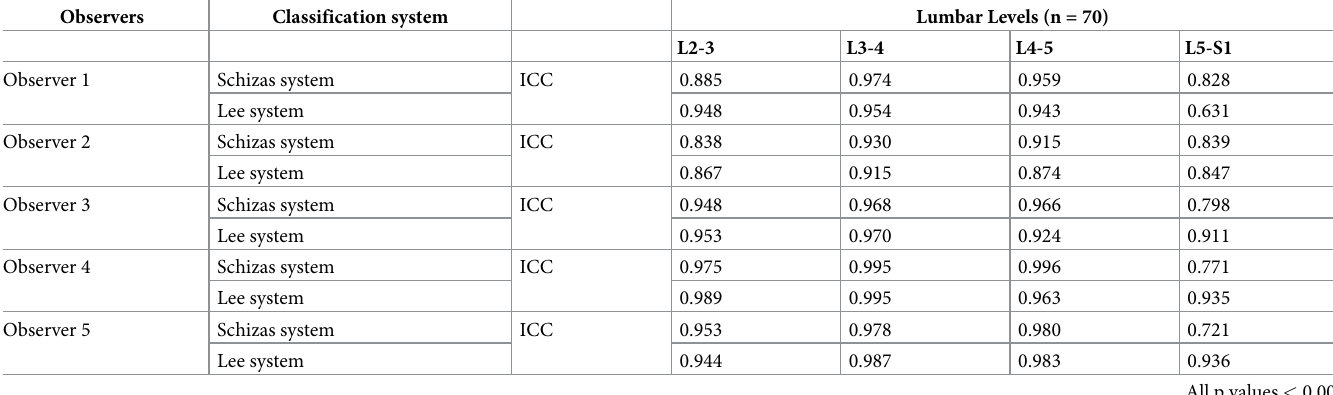
Table 4. Test-retest reliability of the Schizas and Lee